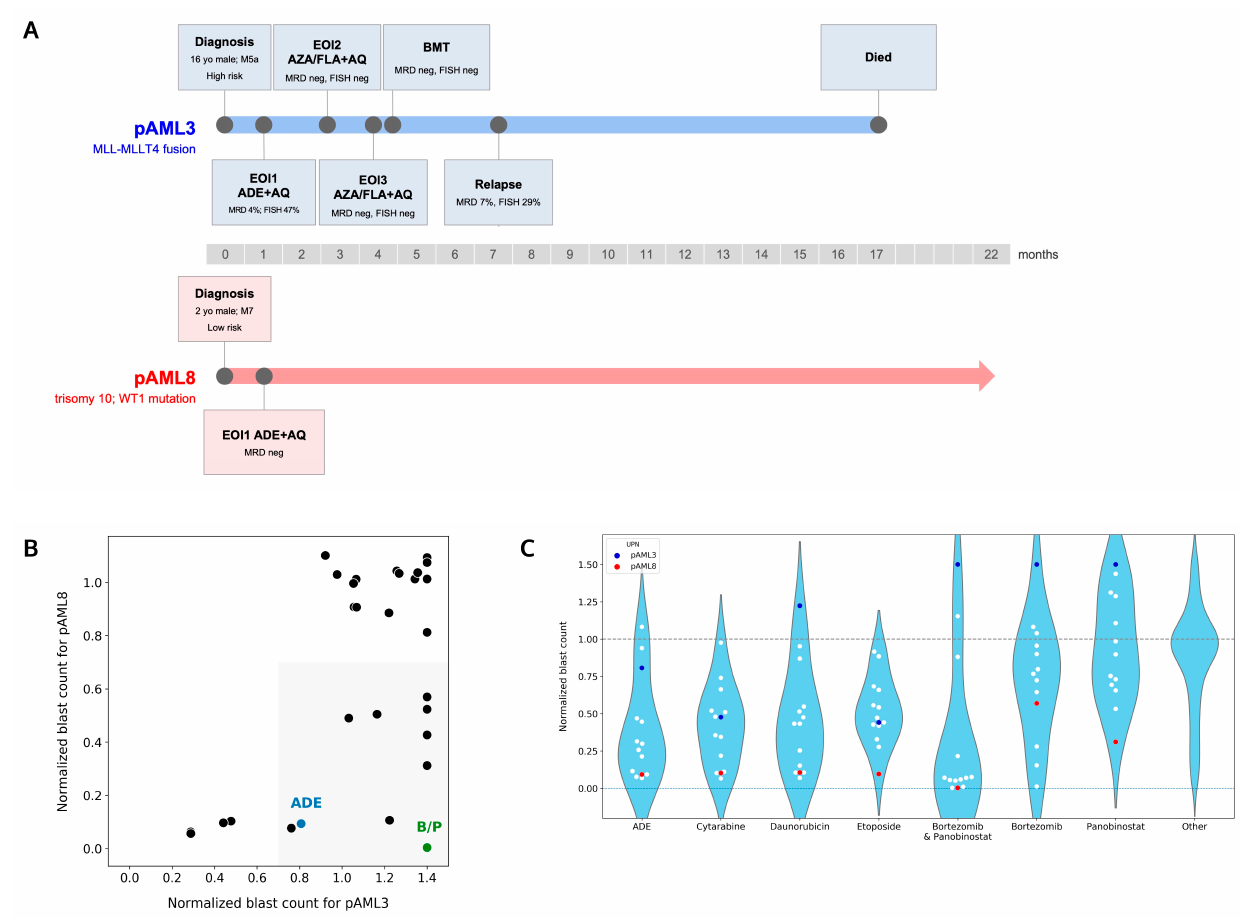
Figure 3. Patients pAML3 and pAML8 show distinct ex vivo drug sensitivity profiles. ( A ) Disease course and treatment timelines for patients pAML3 and pAML8. ( B ) Scatterplot comparing normal- ized blast counts for patients pAML3 (x-axis) and pAML8 (y-axis) in response to 29 matched drug conditions assayed ex vivo. Shaded region indicates conditions that showed sensitivity for patient pAML8 and not for patient pAML3. B/P = bortezomib/panobinostat. Normalized blast counts > 1.4 are shown as 1.4. ( C ) Violin plot comparing the distribution of normalized blast counts for 13 patients in response to the indicated conditions. “Other” is the mean of the remaining 30 treatment conditions included in the DSP. Patient pAML3 is indicated in blue; patient pAML8 is indicated in red. Lower dashed line at y = 0 indicates no blasts remained following incubation with drug. Upper dashed line at 1.0 indicates no change in blast counts relative to DMSO control. Normalized blast counts > 1.5 are shown as